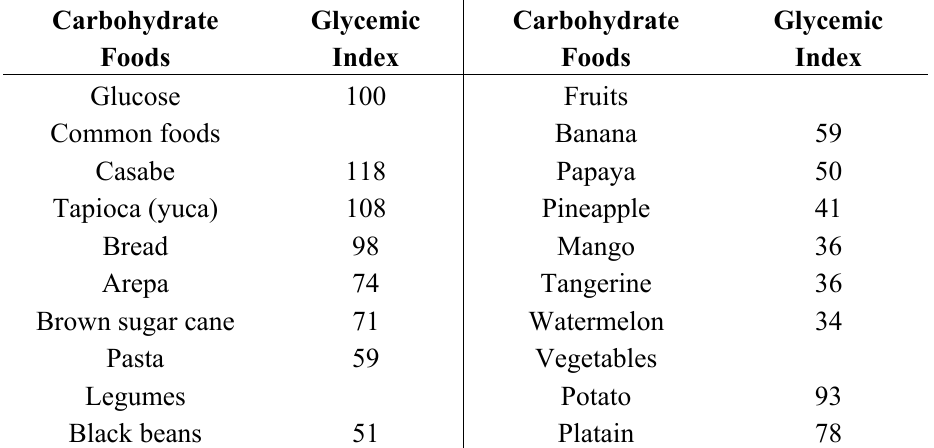
Glycemic index (GI) ranks carbohydrates according to their effect on blood glucose levels. High GI ≥ 70; medium GI 56–69; low GI ≤